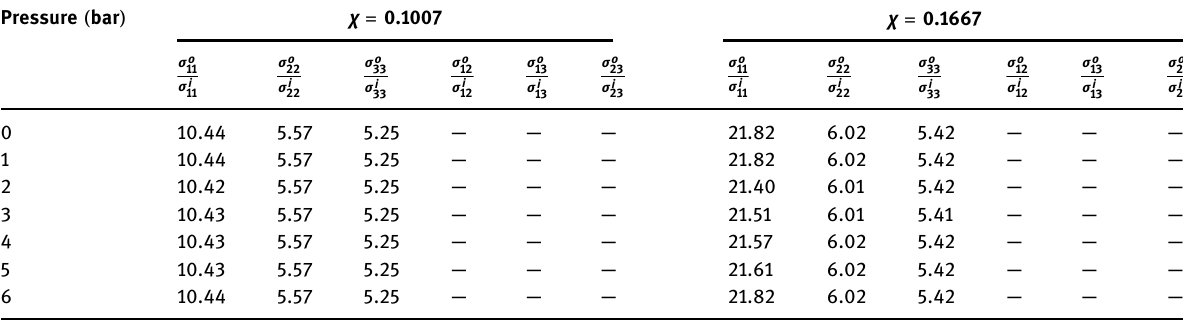
Table 6: Ratio of stress between inner and outer sheets Pressure ( bar )